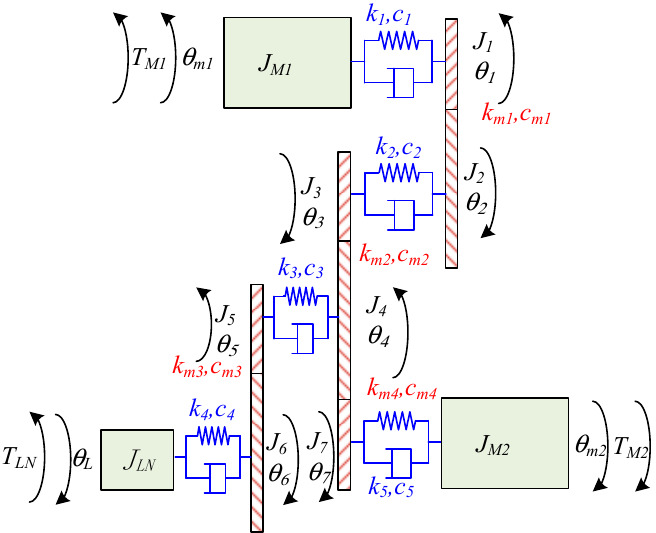
Figure 8. Schematic diagram of the transmission system of the DEDS.